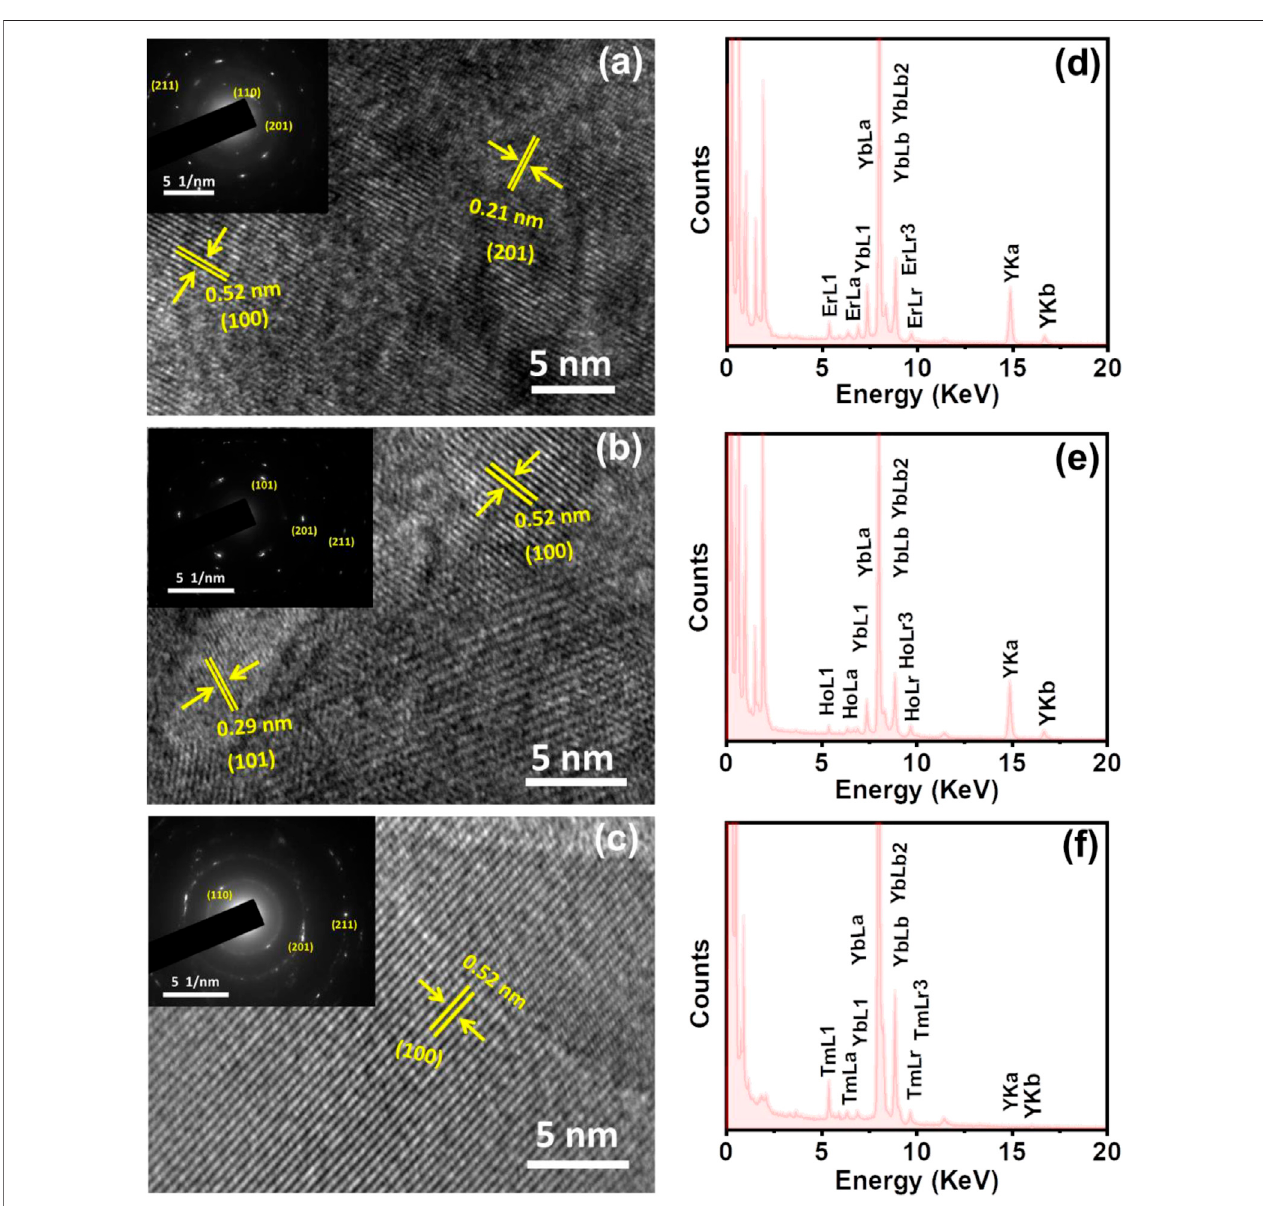
FIGURE 5 | HRTEM images of the ligand free (A) NaYF 4 :Yb/Er, (B) NaYF 4 :Yb/Ho and (C) NaYF 4 :Yb/Tm UCNPs showing the corresponding lattice planes (the nanophosphors are synthesized under optimised reaction conditions discusses above ( vide supra ). The inset in each image shows the corresponding SAED pattern (D – F) EDAX spectra of (D) NaYF 4 :Yb/Er, (E) NaYF 4 :Yb/Ho and (F) NaYF 4 :Yb/Tm UCNPs showing the presence of constituent elements in each